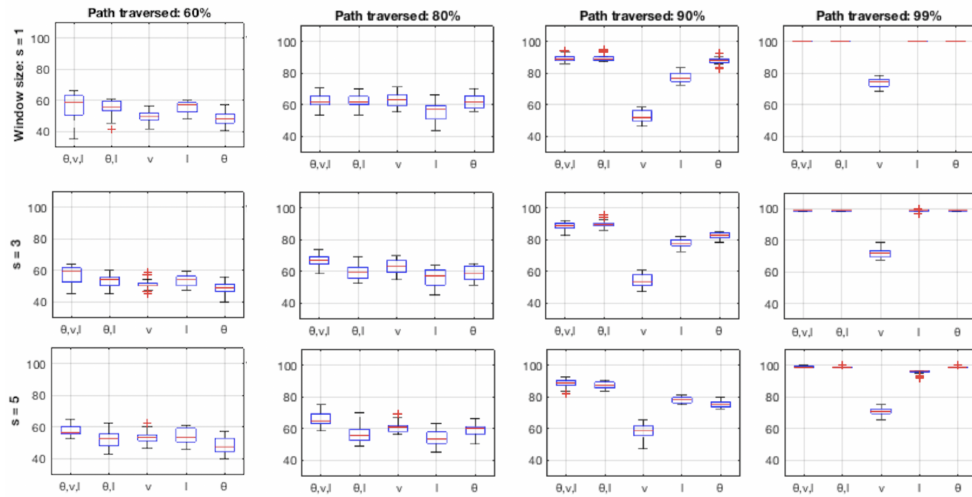
Figure 16. Aggregate results on bicycle dataset using decision trees with history voting over a sliding window—three rows of the subplots (from top to bottom) correspond to window sizes of 1, 3 and 5, and each of the four columns (from left to right) correspond to 60%, 80%, 90% and 99% of the total path length traversed (cf. Figure